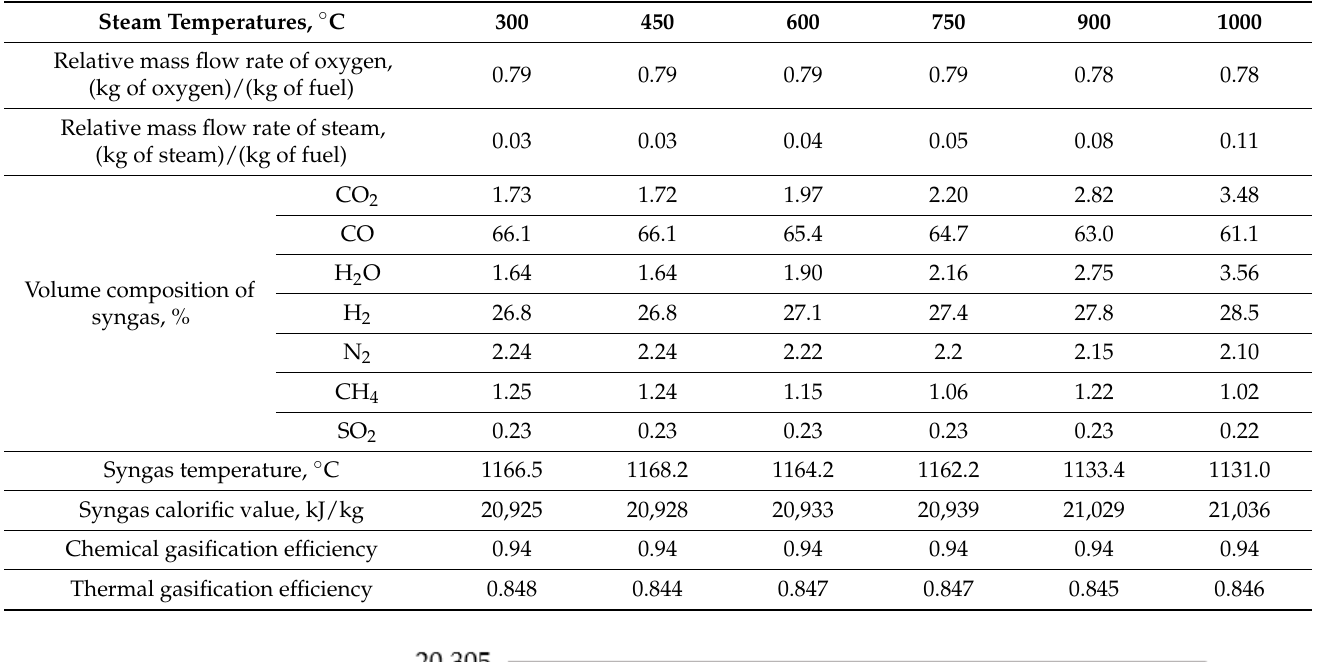
Table 7. Optimal values of output parameters for steam temperatures under consideration and corresponding relative mass flow rates of oxygen.